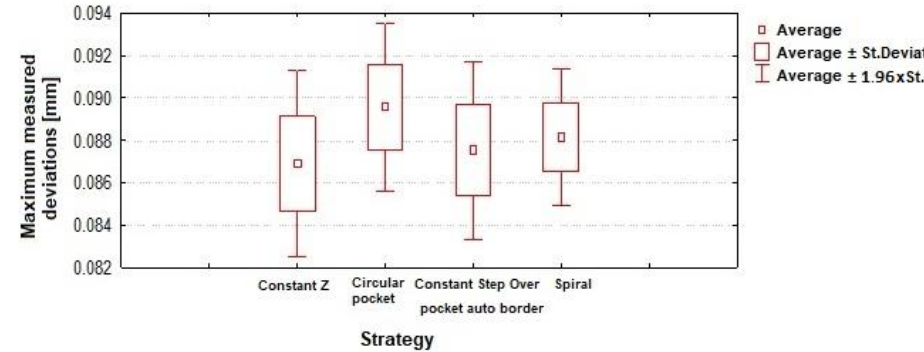
Figure 17. Roundness deviations using UPR filter.